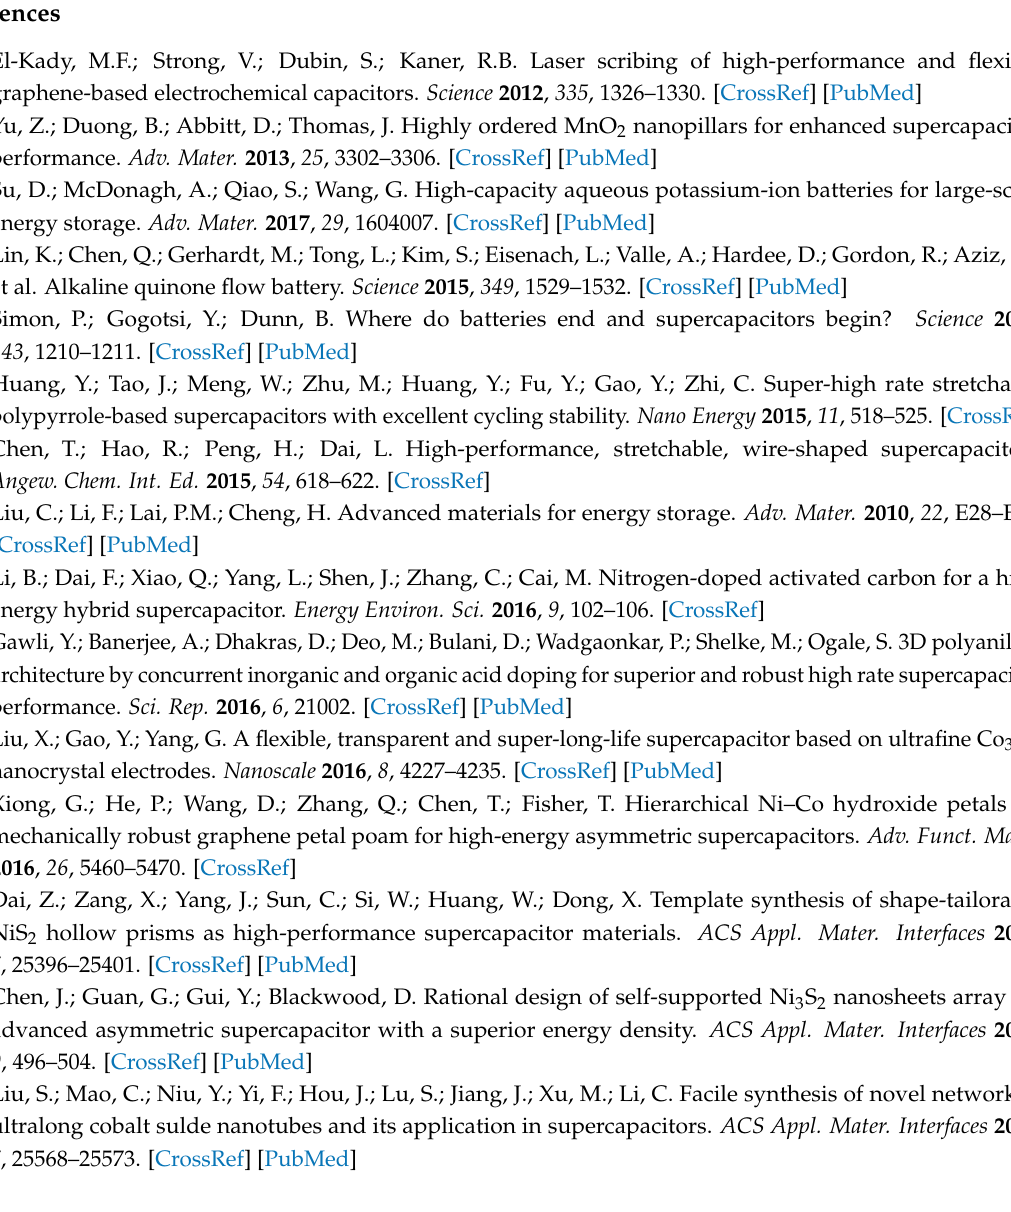
Figure S1: SEM images of (a) CuO/Cu 2 O@NiCo 2 S 4 –1, (b)CuO/Cu 2 O@NiCo 2 S 4 –2, (c) CuO/Cu 2 O@NiCo 2 S 4 –3, (d)